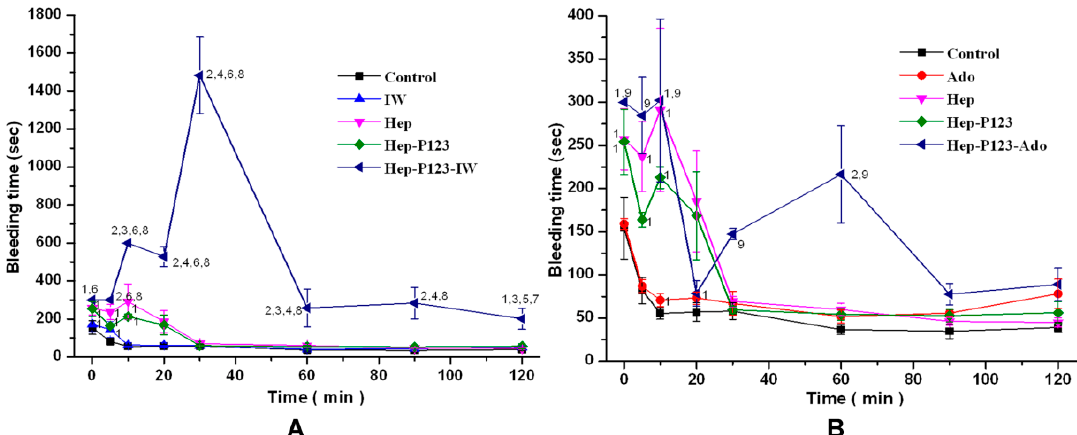
Figure 7. Bleeding time. Influence of the IW ( A ) and Ado ( B ) as well as their encapsulated forms on the bleeding time in comparison with Hep and Hep-P123. M ± m. n = 9 for each group. The numbers near the points indicate the probability values ( p ). 1 − p < 0.05 and 2 − p < 0.01 compared with control. 3 − p < 0.05 and 4 − p < 0.01 compared with Hep. 5 − p < 0.05 and 6 − p < 0.01 compared with IW. 7 − p < 0.05 and 8 − p < 0.01 compared with Hep-P123. 9 − p < 0.01 compared with Ado.